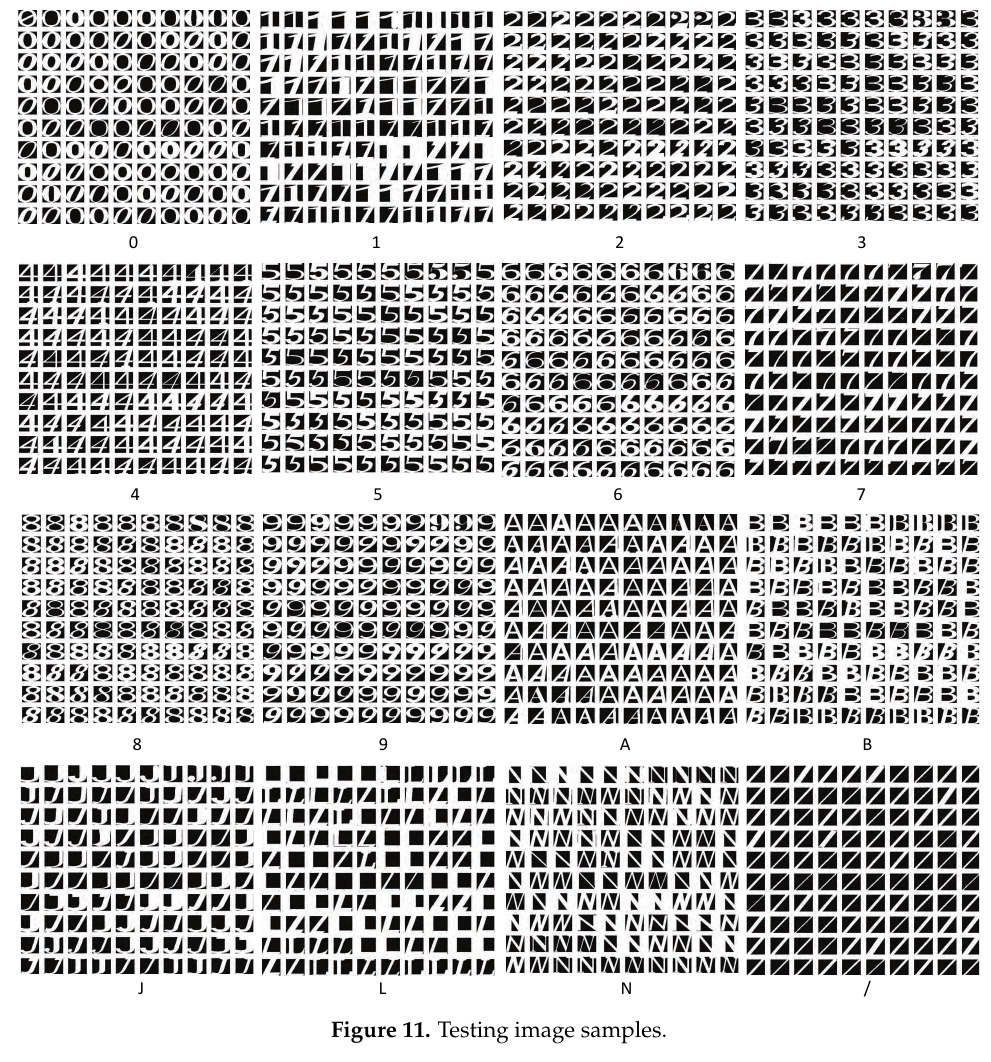
Figure 11. Testing image samples.